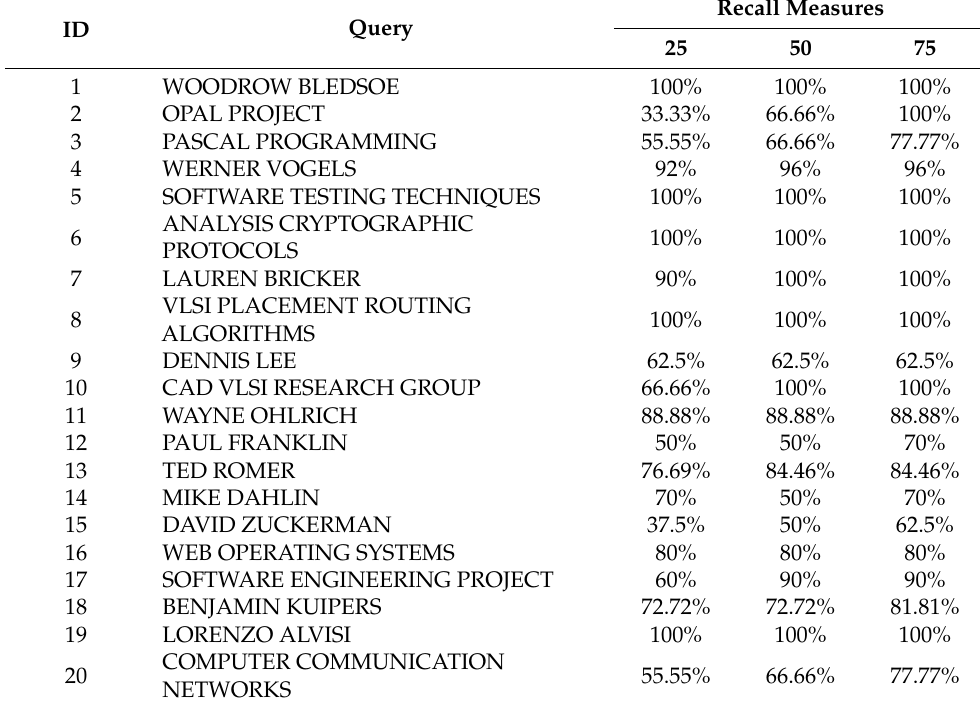
Table 9. Recall measure of the population by (25, 50, 75) size.